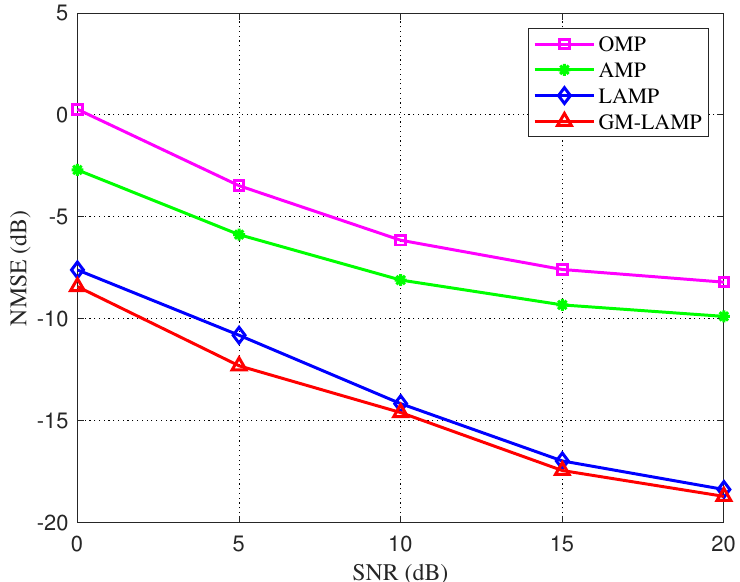
Figure 2. NMSE performance comparison of each channel estimation scheme for UPAs based on the Saleh-Valenzuela channel model in the mixed resolution ADC architecture.